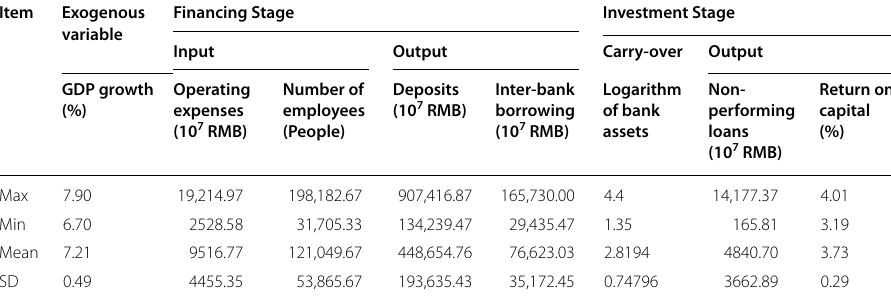
Table 4 Statistical Description of inputs and